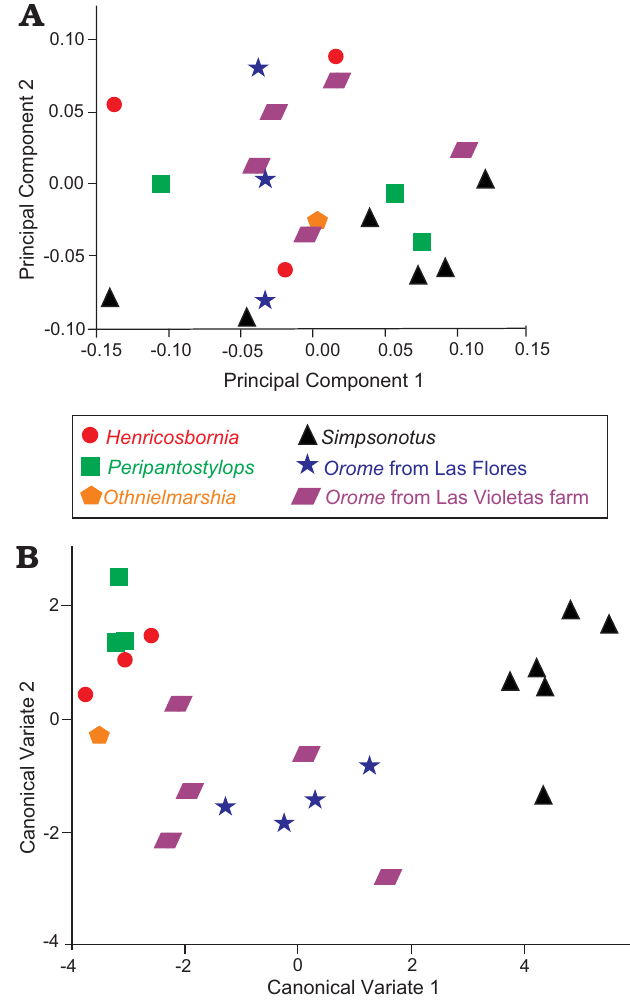
Fig. 7. Geometric morphometric analyses. A . Principal Component Ana- lysis. B . Canonical Variate